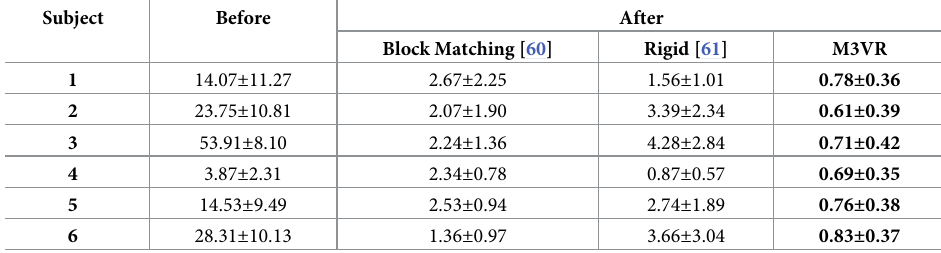
Table 1. Cross validation results on the registration accuracy of the levator ani muscle. MDE—Mean Distance Error